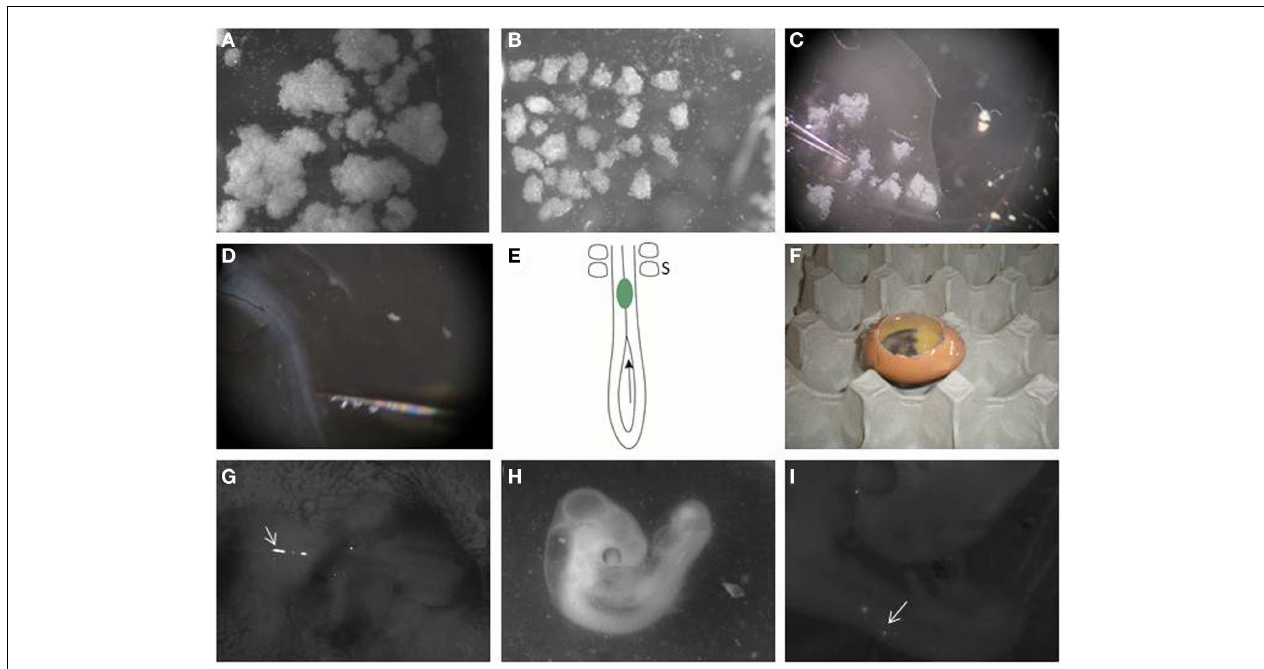
which can then be pushed or injected into the neural tube so it lies just caudal to the most caudal somites (S). (F) Eggs are then re-sealed with transparent tape and allowed to incubate for 48h. (G) Clusters of DiO-positive melanoma cells can be seen in the trunk neural tube immediately after injection when imaged using a fluorescence stereomicroscope (arrow).The head of the embryo is to the right. (H) Embryo is processed 2days following injection. (I) DiO-positive melanoma cells can be seen under a fluorescence stereomicroscope in the trunk neural tube and in the surrounding tissue